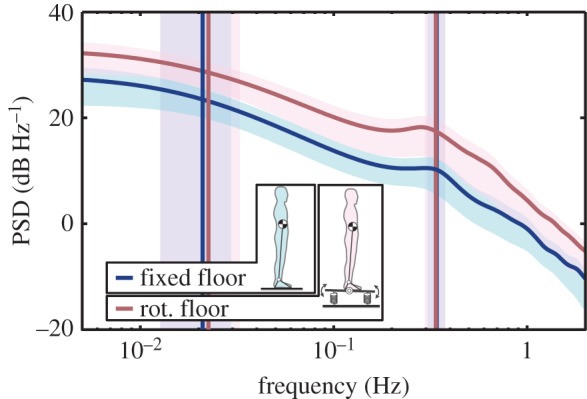
Power spectrum density (PSD) of the centre of pressure (COP). Curved lines are the PSD of measured COP derived by the maximum entropy method. Blue and red vertical lines indicate the characteristic frequencies of the PSD, calculated by the minimum frequency of the second differential values. Blue and red areas are the standard deviations of the PSD and the characteristic frequencies.